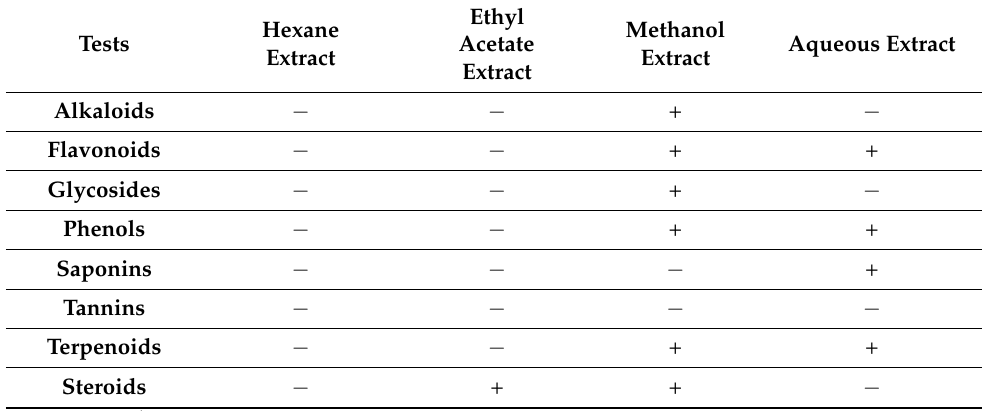
Table 2. Total phenolic and flavonoid contents of B. hochstetteri fractions. Total Phenolic Content Flavonoid Content S. No Fraction ( µ g GAE/g of d. wt.) ( µ g QE/g of d. wt.) 1 Methanolic fraction 3210 1863 Aqueous fraction 2552